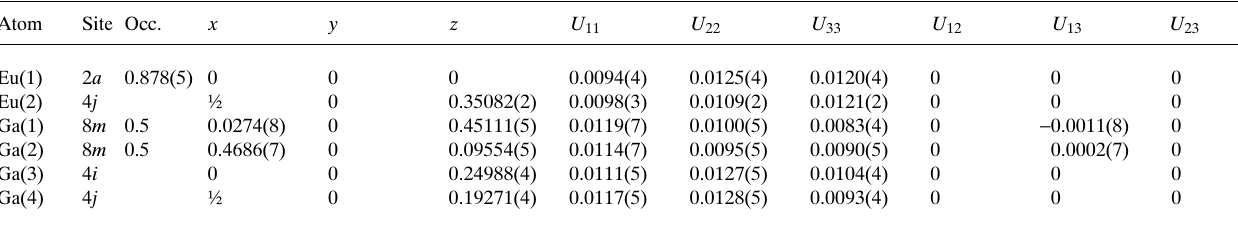
Table 3. Atomic coordinates and displacement parameters (in Å 2 ) .